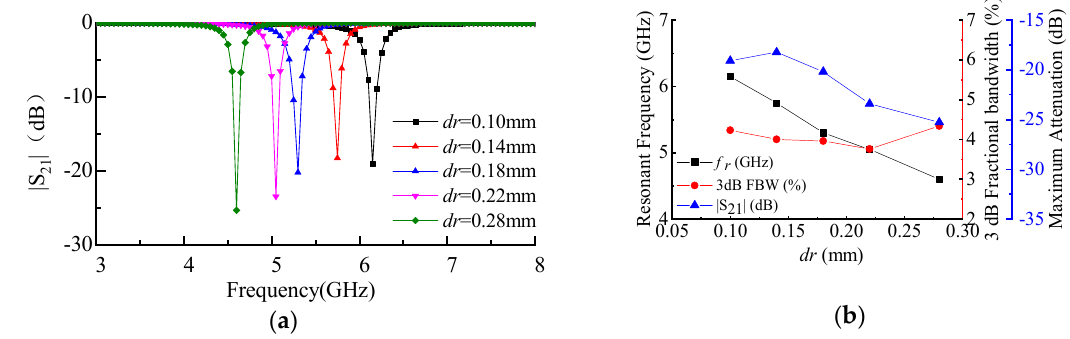
Figure 6. ( a ) Simulation results with different dr by using HFSS. ( b ) Resonant frequency, maximum attenuation, and 3 dB Fractional Bandwidth with different dr.